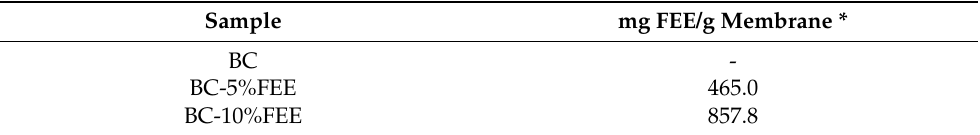
Table 8. The FEE content in each BC-membranes applied in the